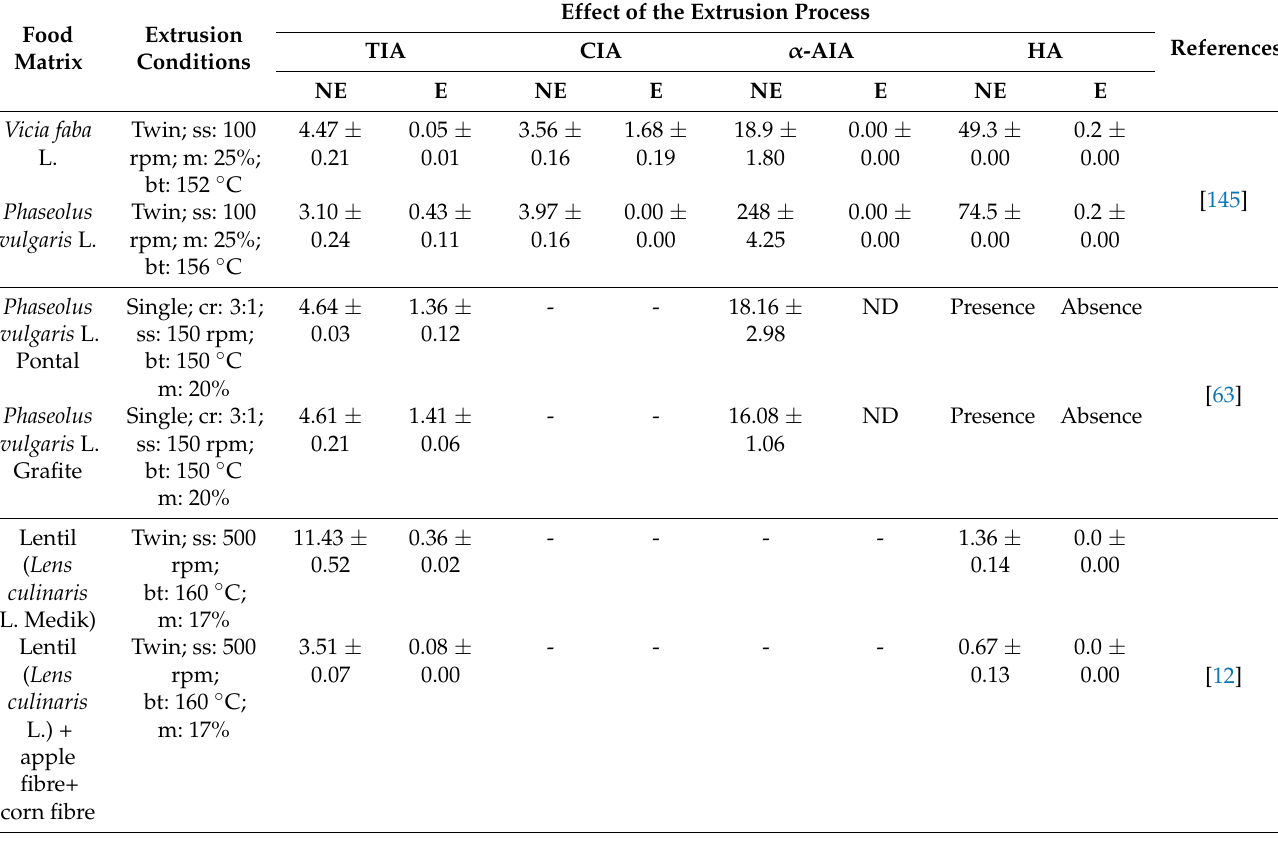
Table 6. Effect of extrusion process on some antinutrients (enzyme inhibitor and hemagglutinins) of different pulses. Food